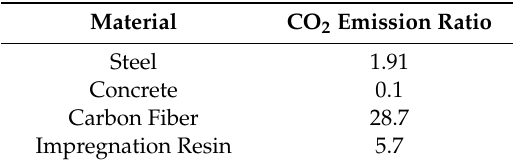
Table 7. CO 2 emission ratios (wt. /